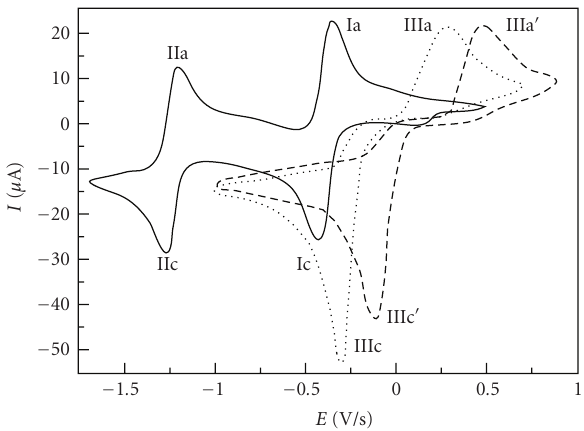
Figure 1: Typical cyclic voltammetry of 2.0mM 1,4-benzoquinone, in DMSO +0.2M Bu 4 NPF 6 , on glassy carbon electrodes ( φ 3mm) at 0.1 Vs − 1 . Several concentrations of benzoic acid were used: (solid line) 0.0 M; (dotted line) 0.03 M and (dashed line) 1.00 M. [174].